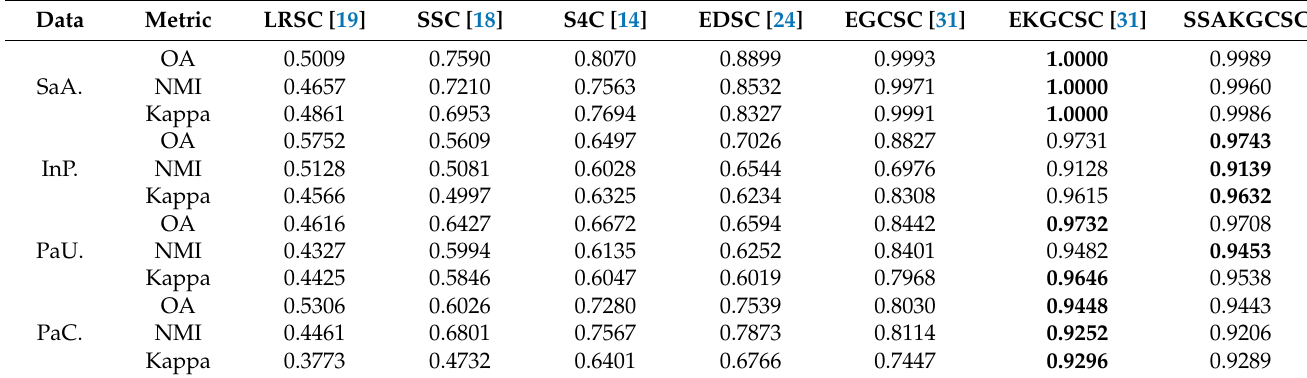
Table 3. Clustering performance of the compared methods on SalinasA, Indian Pines, Pavia Univer- sity, and Pavia Center data sets.